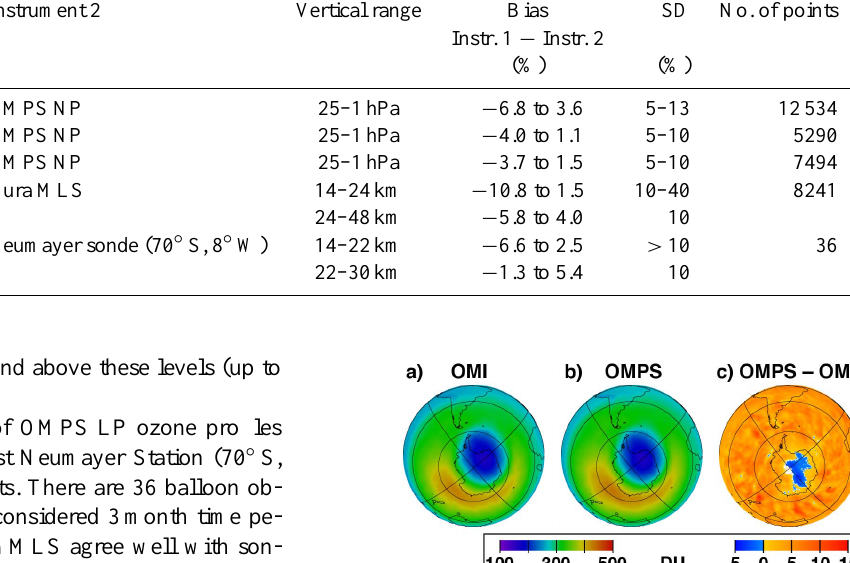
Table 1. Summary of ozone profile comparisons over 55–82 ◦ S in September–November 2012 (SD, standard deviation). Instrument 1